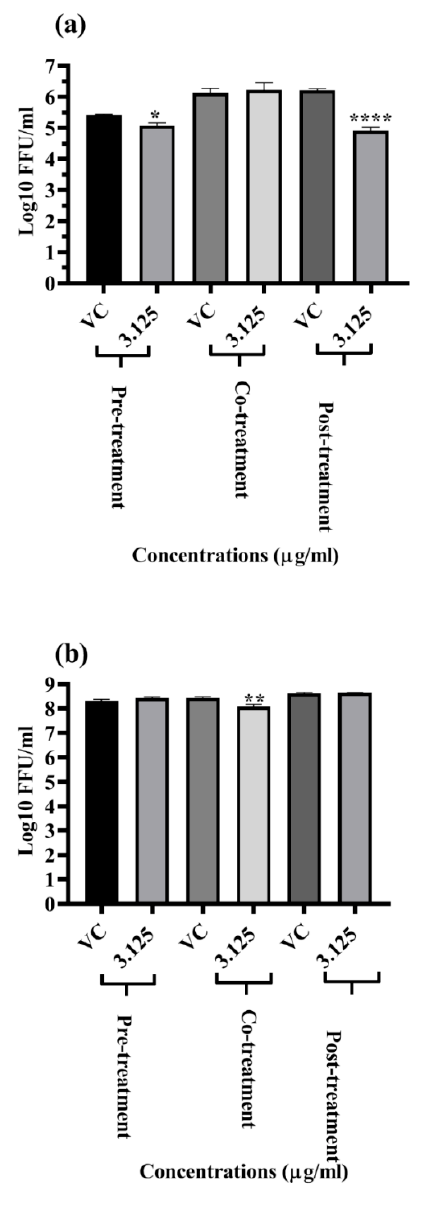
Figure 2. Antiviral screening of LFOB at maximum non-toxic concentration against ( a ) DENV and ( b ) CHIKV under pre-, co-, and post-treatment conditions. All the treatment conditions were compared with the virus control. **** p value < 0.0001, ** p < 0.01, * p < 0.05 vs. control.